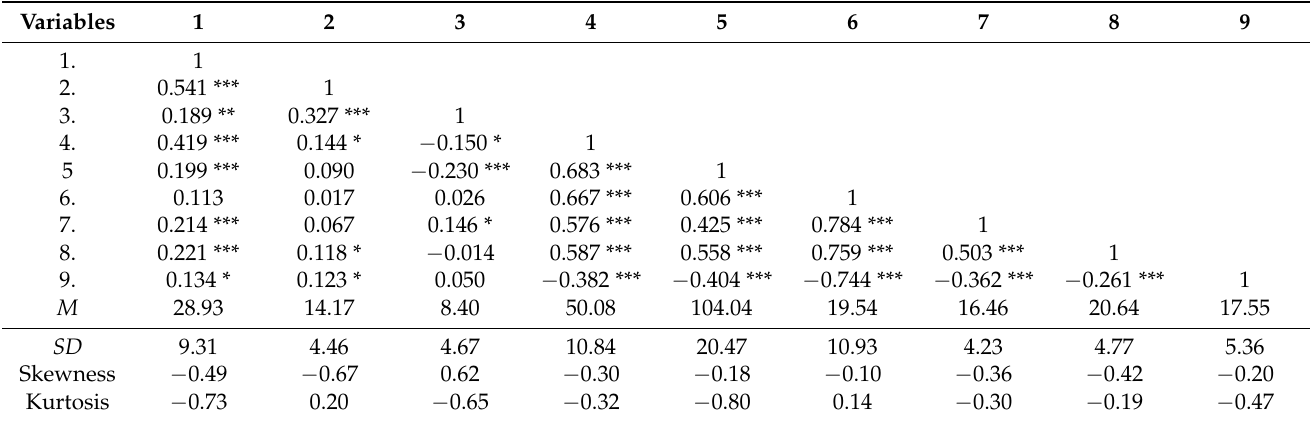
Table 2. Correlational matrix of religiosity, existential consciousness, savoring belief, and subjective well-being of middle-aged Korean women ( N =